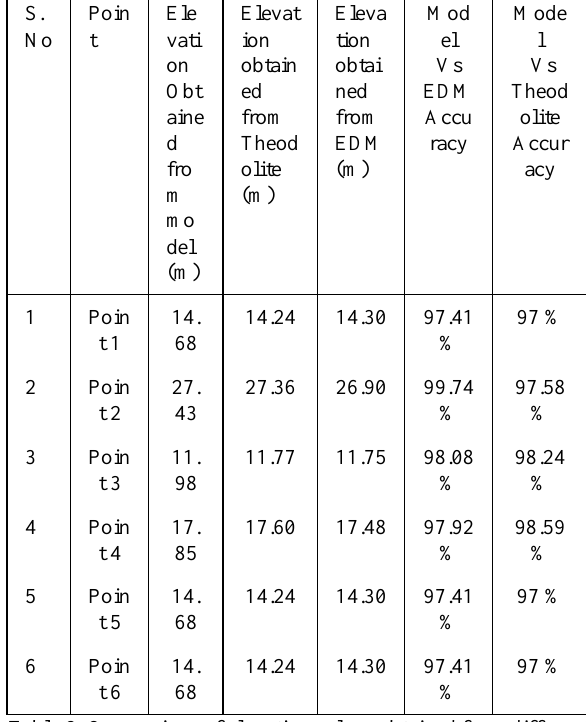
Table 2. Comparison of elevation values obtained from different